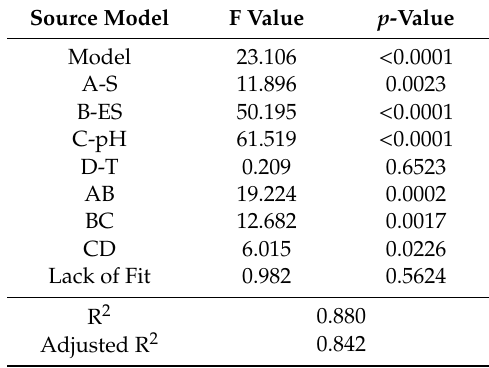
Table 2. Analysis of variance of the experimental design to evaluate the e ff ect of substrate concentration (S), enzyme substrate ratio (E / S), pH, and temperature (T), on the hydrolysis of